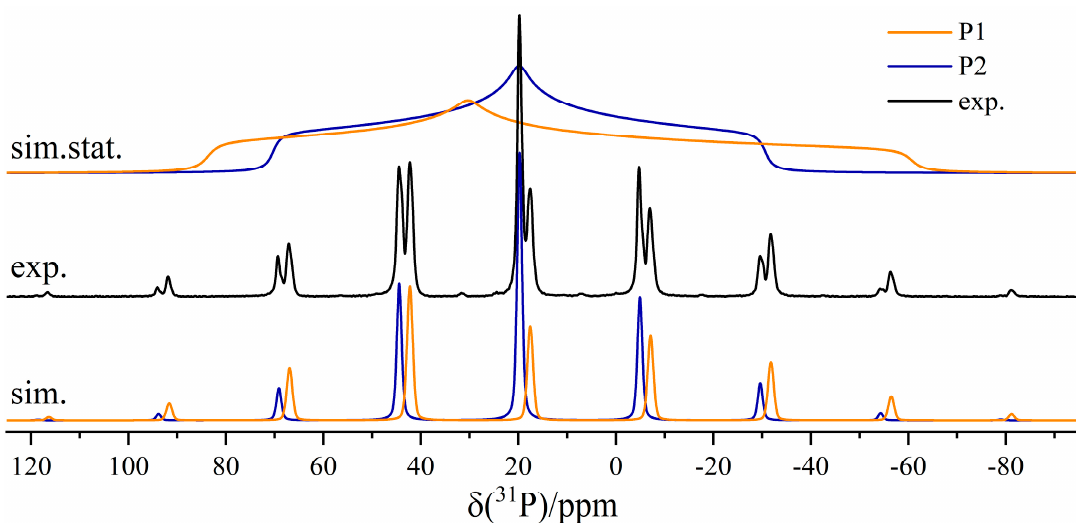
Figure 33. Experimental and simulated slow-spinning 31 P MAS NMR spectra (spinning frequency 3 kHz) of the cyclooctamer 9 , revealing clear differences in the 31 P chemical shift anisotropies of the two phosphorus sites. Simulations of the corresponding static 31 P NMR spectra are included as well.